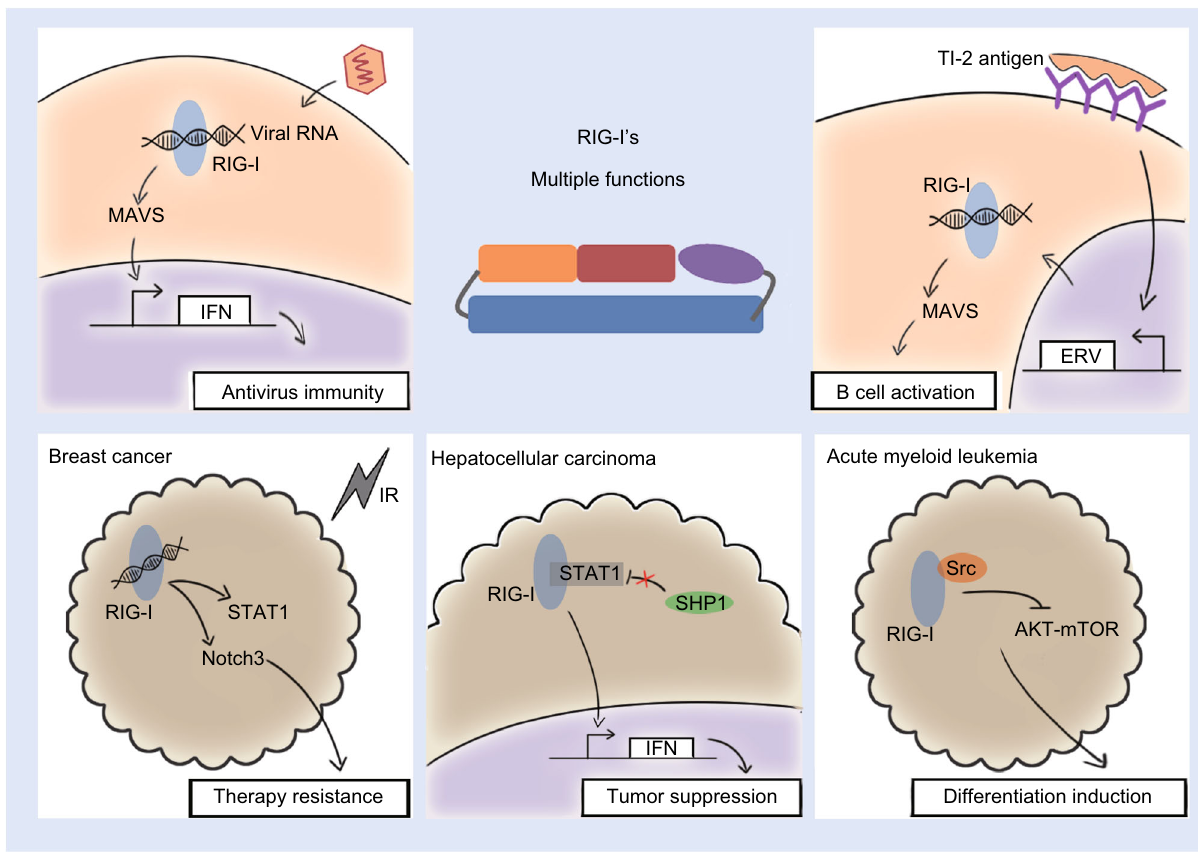
Figure 2. Multiple functions of RIG-I. RIG-I equally exerts versatile functions in immunity and cancer along with its sensing ability of diverse RNAs. For example, RIG-I can initiate IFN synthesis in antiviral responses and promote IgM production in TI-2 B cell activation. RIG-I can also simultaneously help cells resist therapy and facilitate cell expansion in BrCa, suppress tumor growth in HCC and induce differentiation in